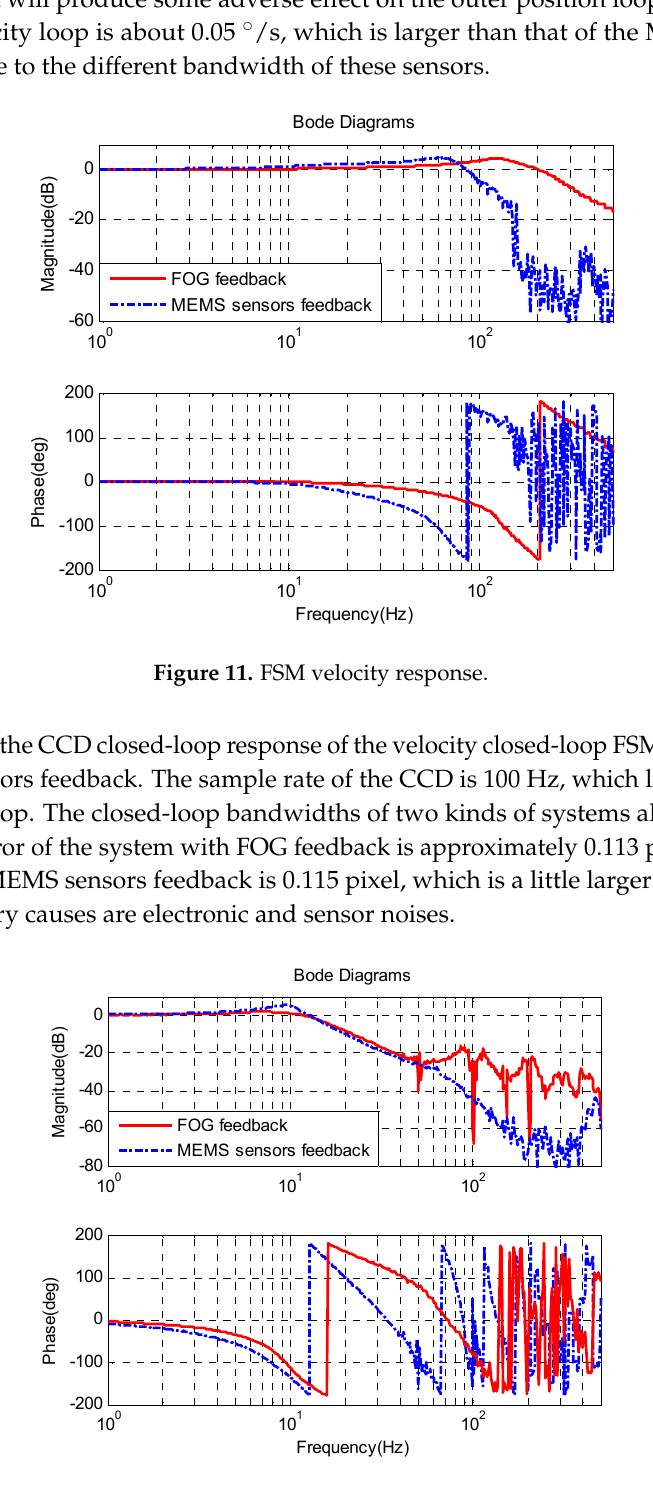
Figure 12. CCD closed-loop response.